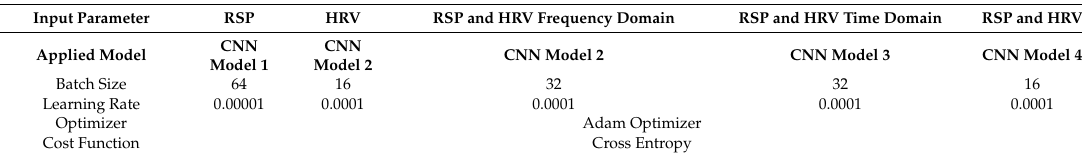
Table 4. Hyper-parameters applied to CNN Models 1–4.